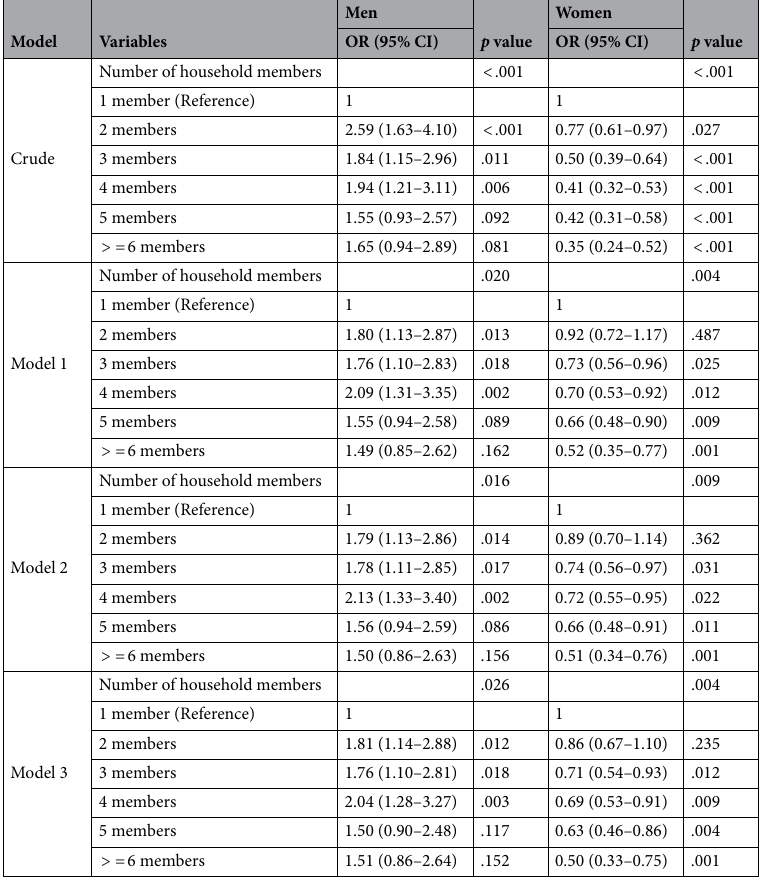
Table 4. Adjusted odds ratios for PUD according to the number of household members. OR odds ratio, CI Confidence interval. Model 1: Adjusted for age and body mass index. Model 2: Adjusted for age,